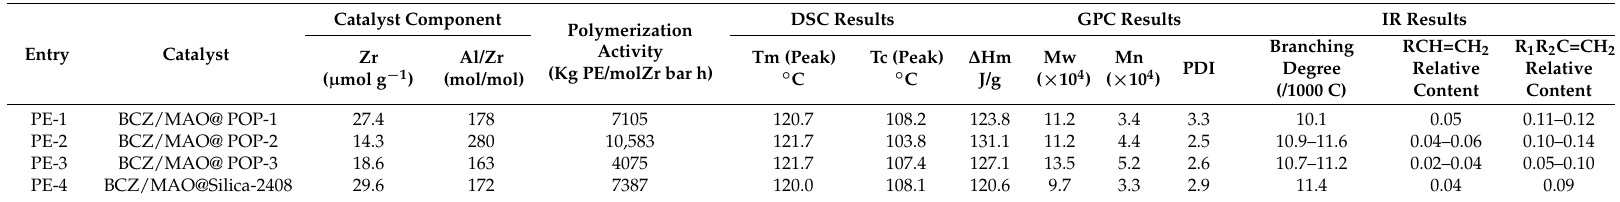
Table 2. Ethylene/1-hexene polymerization activities, differential scanning calorimetry (DSC) and gel permeation chromatography (GPC) results of polyethylene (PE) from the POPs-supported n -BuCp 2 ZrCl 2 /MAO metallocene catalysts. PDI: polydispersity